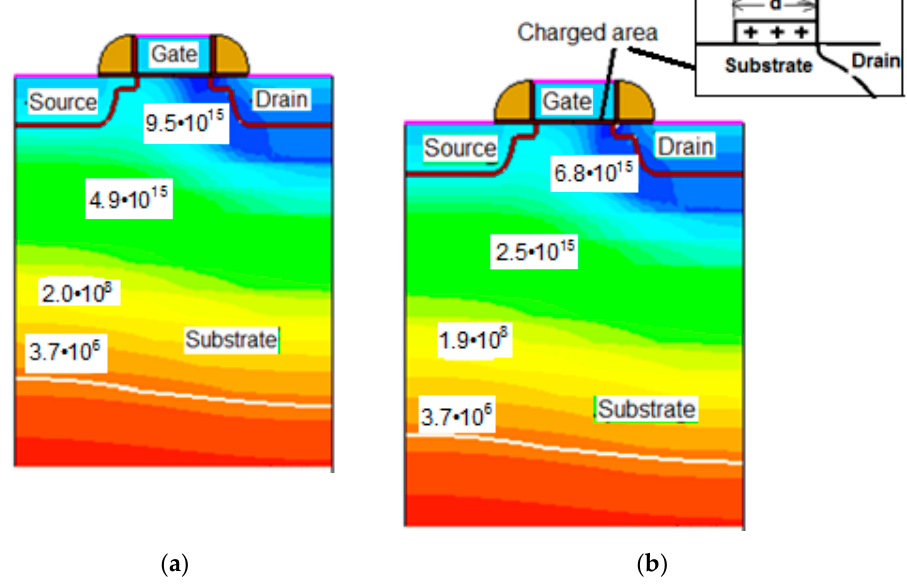
Figure 4. Minor carrier concentration distribution in substrate (base) in case of absence ( a ) and presence ( b ) of embedding local oxide charge. V ds = 0.5 V and the indicated concentration is in cm − 3 .